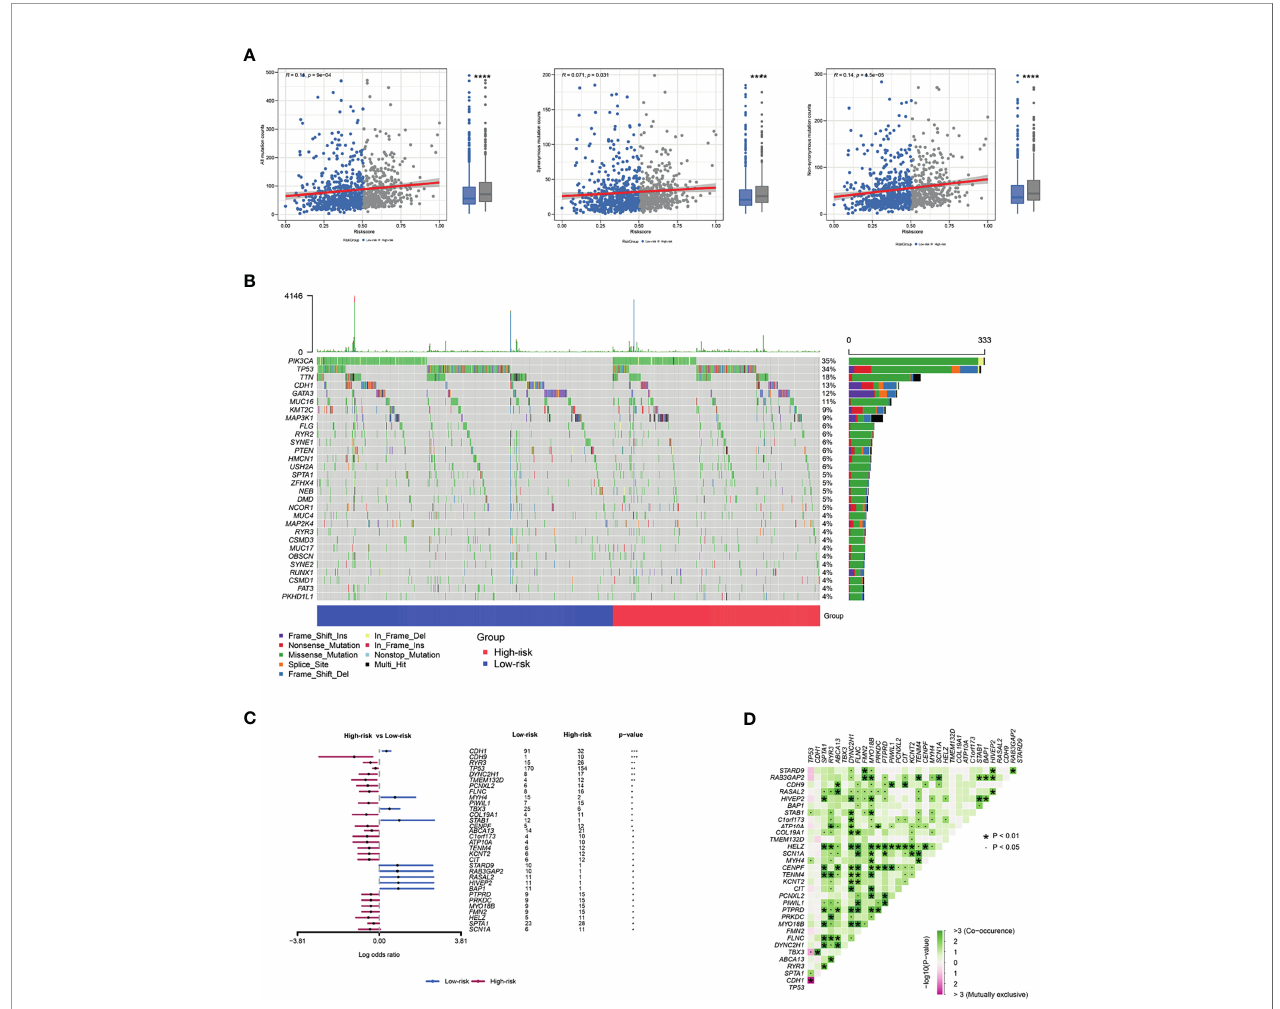
FIGURE 5 | The relationship between risk score and BRCA immune signature. (A) Association between all mutation counts, synonymous mutation counts, non- synonymous mutation counts and risk score and their distribution in the low- and the high-risk groups. (B) Landscape of mutation status in all samples. (C) Forest plot of genes mutating differentially in patients of different groups. (D) Interaction effect of genes mutating differentially in different groups. * P < 0.05; ** P < 0.01; *** P <